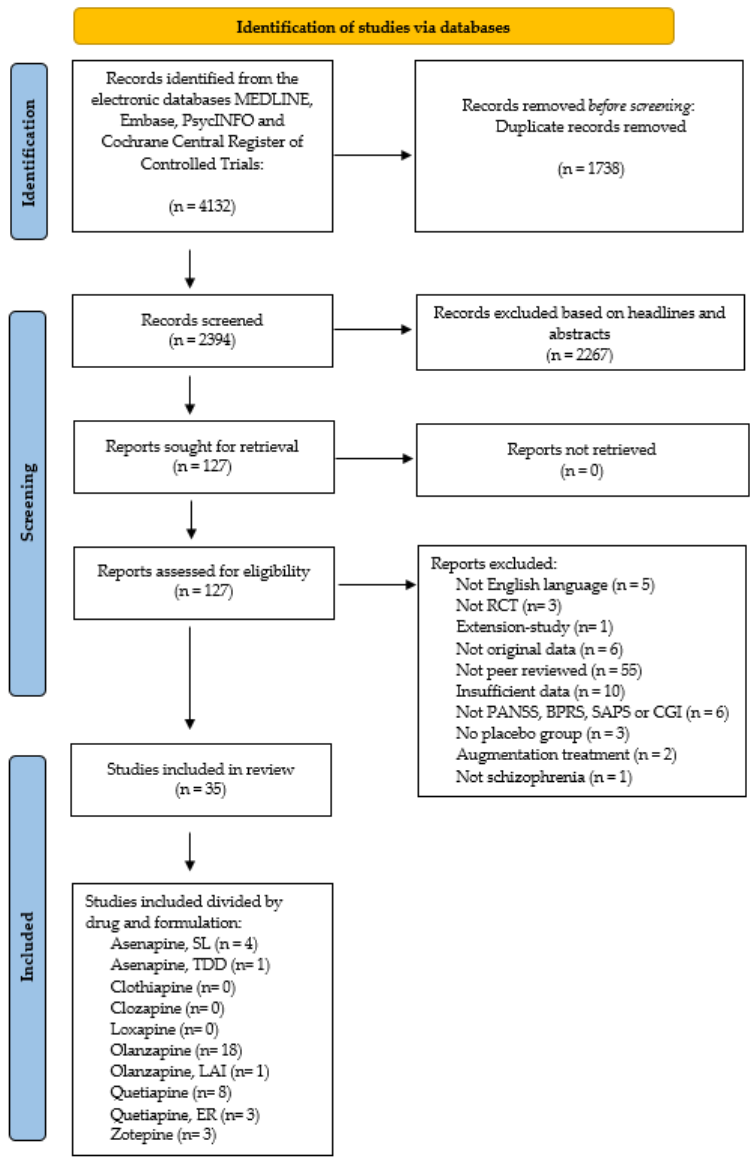
Figure 2. Illustrates the PRISMA flowchart of the study selection process [14]. Since 3 studies [31,57,58] investigated 2 antipsychotics of the -pine group, the sum of studies divided by drug does not correspond to the total number of studies included in the review. [ER = extended-release, LAI = long-acting injectable, SL = sublingual, TDD = transdermal drug delivery].